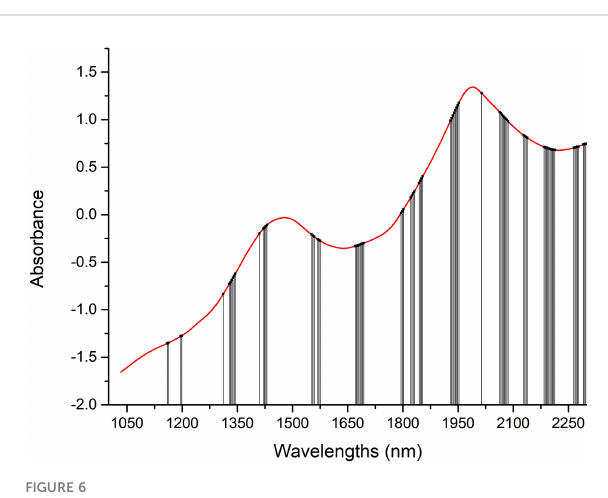
FIGURE 6 Distribution of the 80 effective wavelengths selected by the GA